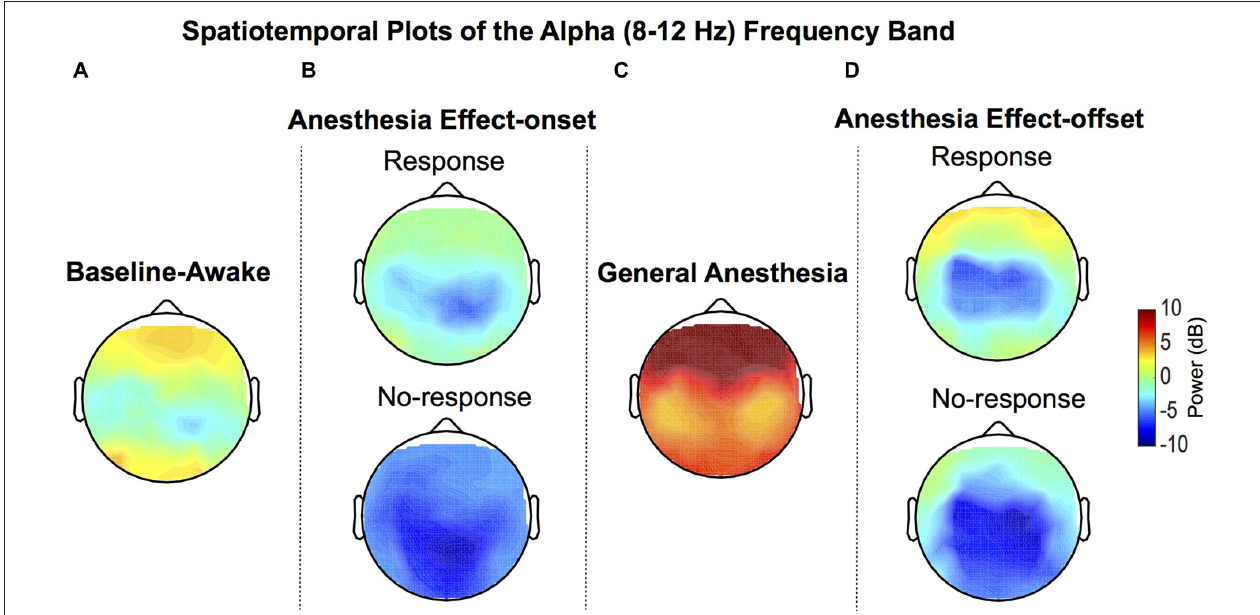
FIGURE 2 | Group-level spatial distribution of alpha power. (A) Alpha oscillations can be observed during the baseline-awake state. (B) Lack of response during sevoflurane anesthesia effect-onset was associated with decreased awake-alpha oscillations compared to response. (C) Large amplitude frontal alpha-oscillations were observed with sevoflurane general anesthesia (GA). (D) Lack of response during sevoflurane anesthesia effect-offset was associated with decreased awake-alpha oscillations compared to